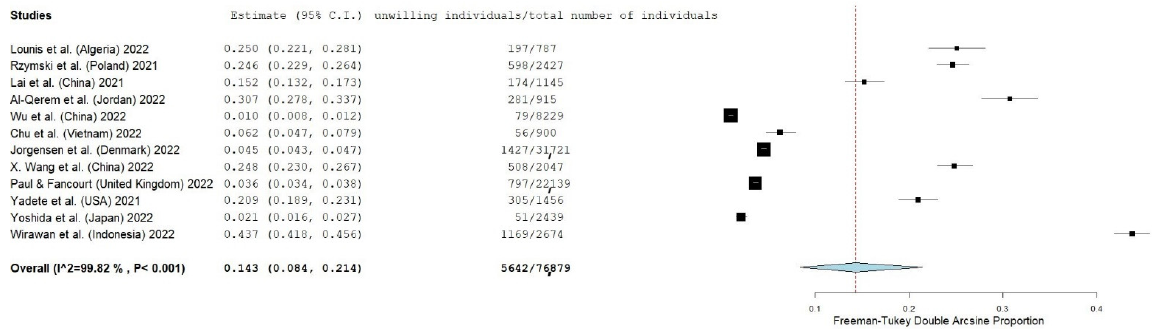
Figure 3. Forest plot of individuals’ refusal to accept a first COVID-19 booster dose. The size of black squares denotes the sample size, while the horizontal line through the square denotes the 95% confidence interval for the refusal proportion.